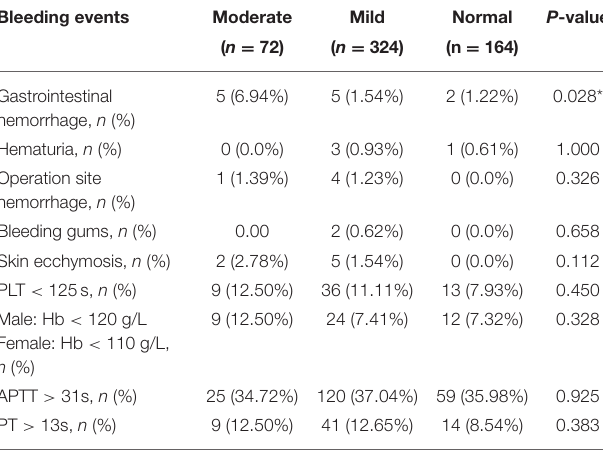
TABLE 3 | Bleeding complications comparison within 12-month